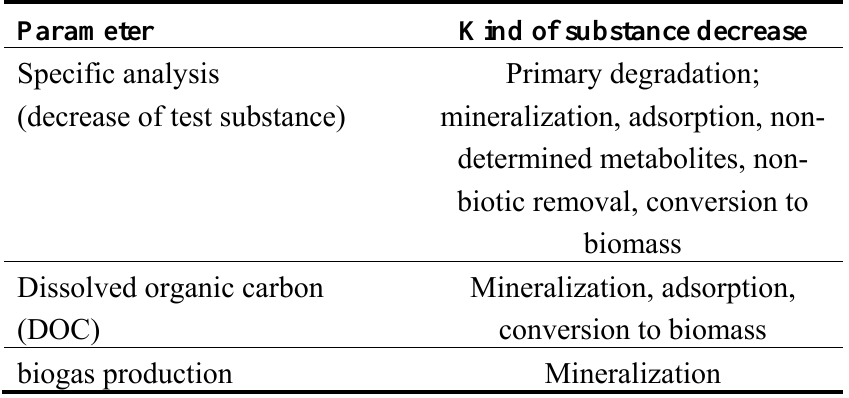
Table 2 . Parameters of anaerobic biodegradation